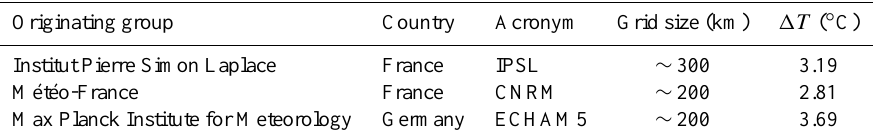
Table 1. Global climate models from CMIP3 database to which CDF-t statistical downscaling method is applied. Their grid size and sensitivity 1T are shown in the last two columns. Their sensitivity is calculated using the global warming produced by the model using the A1B scenario when approximated by linear regression over the 21st century (CSIRO and Bureau of Meteorology, 2007 CSIRO and Bureau of Meteorology, Climate Change in Australia, Technical Report, Australian Greenhouse Office (2007) www.climatechangeinaustralia.gov.au, 148pp., CSIRO and BoM,